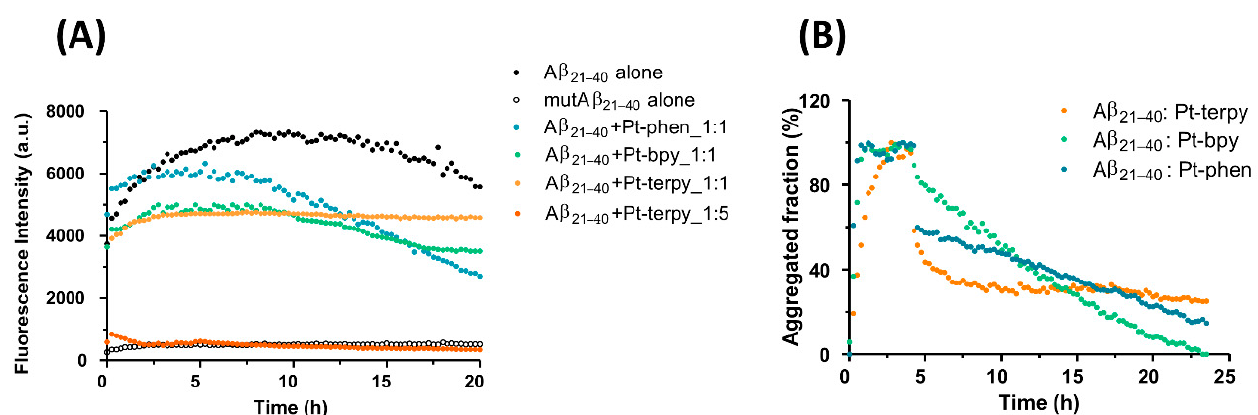
Figure 2. Time course of ThT fluorescence emission intensity of A β 21–40 peptides alone and upon the addition of Pt-phen, Pt-bpy, and Pt-terpy at ( A ) t = 0, at the indicated molar ratios, and ( B ) after 5 h, time of addition is indicated with an arrow, at 1:1 ratio.